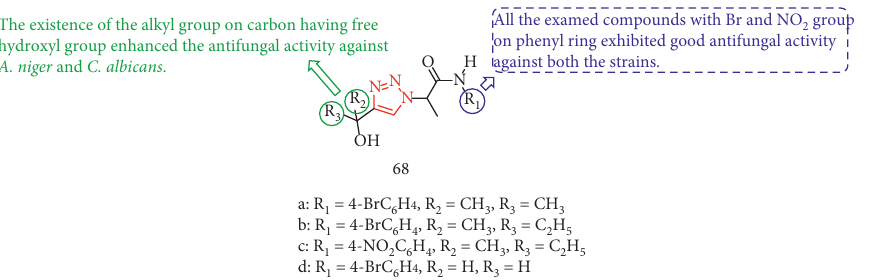
Figure 23: Chemical structure of amide-linked 1,4-disubstituted 1,2,3-triazoles.